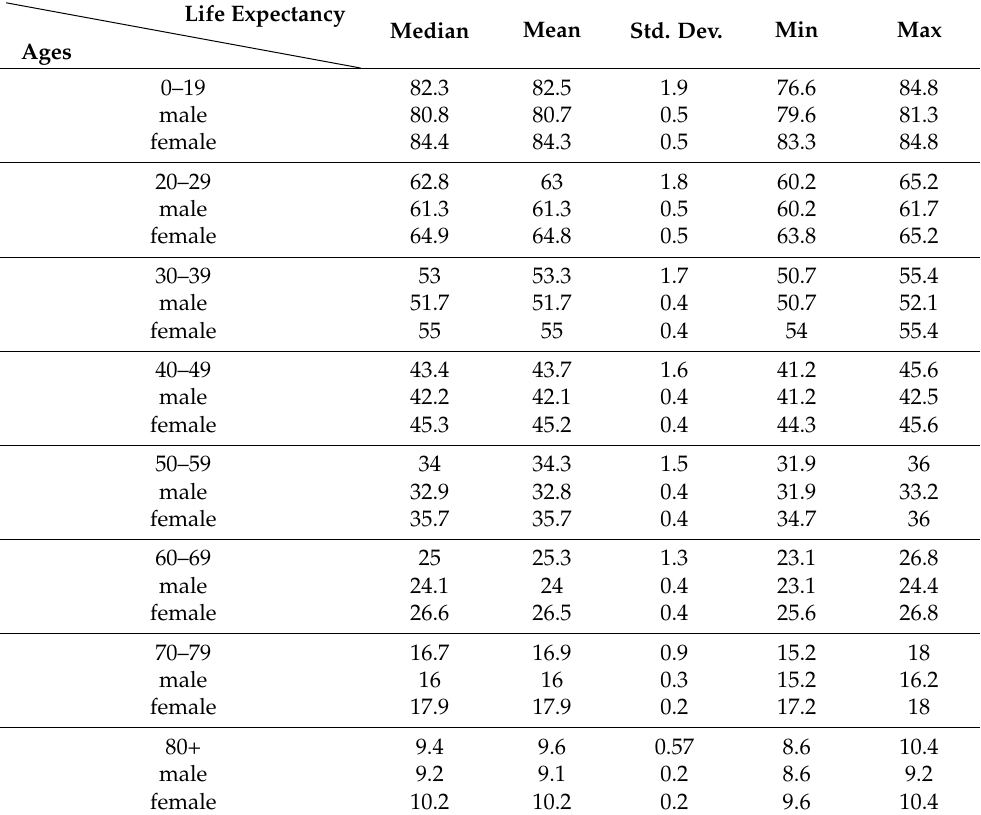
Table 1. Summary Monthly Statistics of Canada and Australia from March 2019 to February 2021, stratified by age and sex.